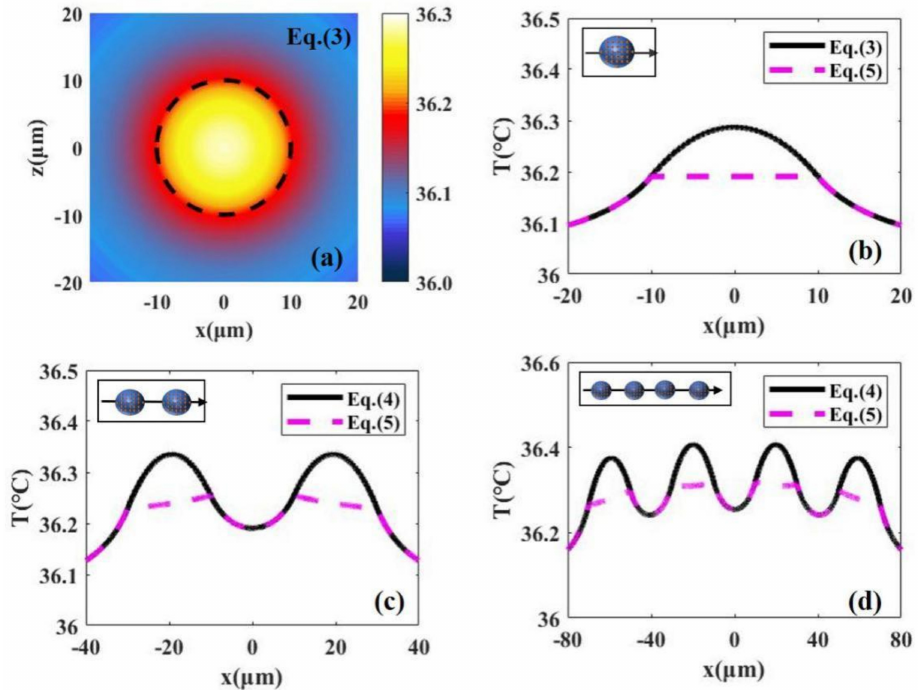
Figure 3. ( a ) The 2D temperature distributions caused by the heat transfer from nanoparticles to a single cell obtained by Equation (2) with laser intensity I = 15 W/cm 2 . ( b ) The 1D temperature distribution along the x axis in ( a ). The 1D temperature distributions in the case of two cells and four cells are shown in ( c ) and ( d ). the red dotted lines in ( b – d ) represent the calculated results using simplified formulas (Equation